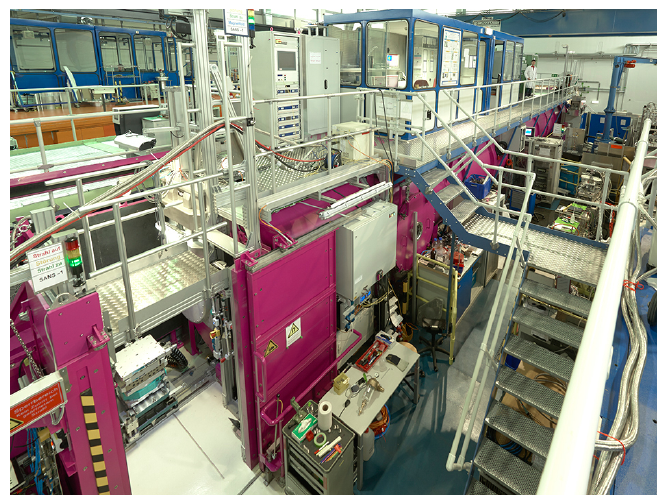
Figure 1: Instrument SANS-1 (Copyright by W. Schürmann,